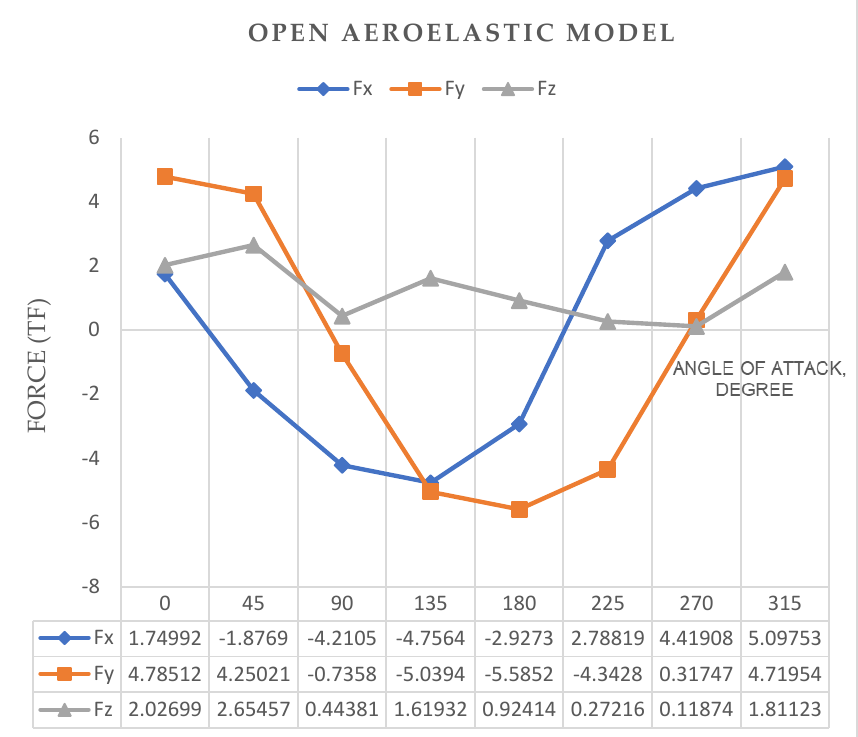
Figure 8. Force curves of Fx, Fy, Fz (tf) for a change in the angle of attack from 0° to 360°, for an open aeroelastic model, Option (0000).